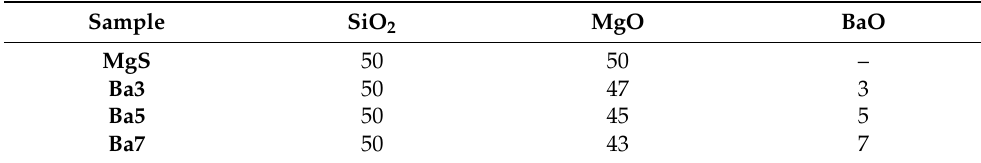
Table 1. Samples compositions (%) adopted in this